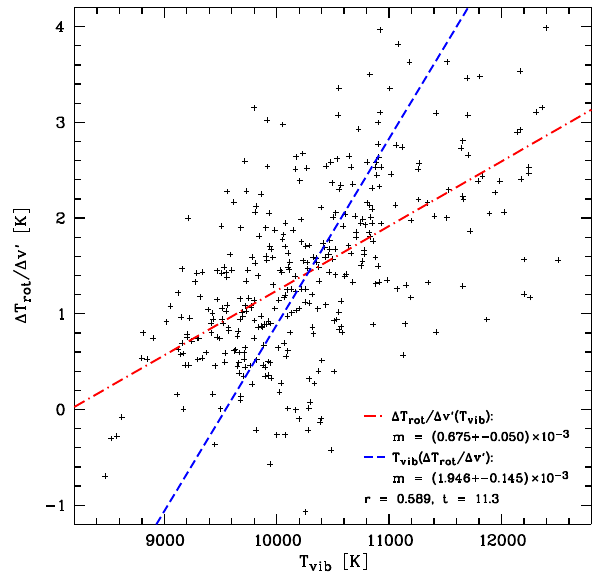
Figure 14. Change of T rot with respect to v (cid:48) (cid:49)T rot /(cid:49)v (cid:48) (cf. Fig. 10) vs. T vib for all v (cid:48) for the individual X-shooter observations and G98 line parameters. The dash-dotted red and dashed blue lines show the results of an regression analysis (see